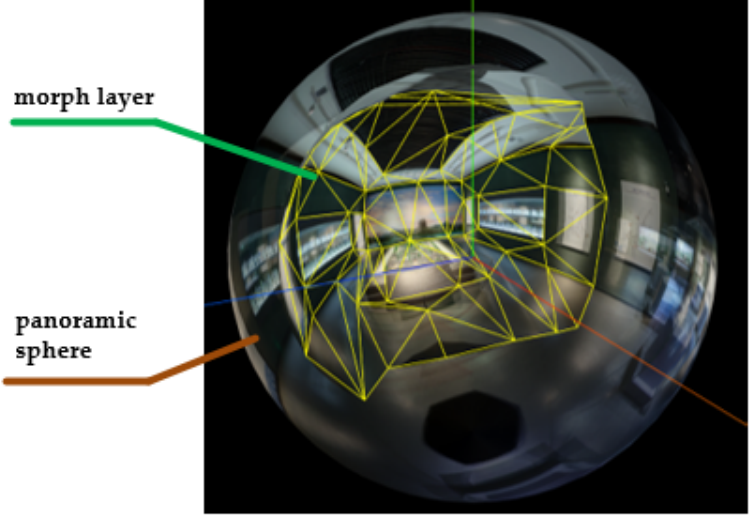
Figure 6. The dynamic panoramic ball display strategy. The outer layer is a panoramic sphere for roaming, and the inner layer is the morph layer for smooth site transitions.